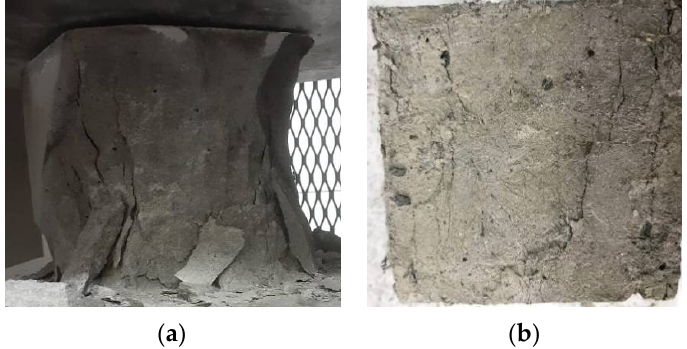
Figure 4. Mode of failure due to compressive strength for plain mortar ( a ) and ECC ( b ).